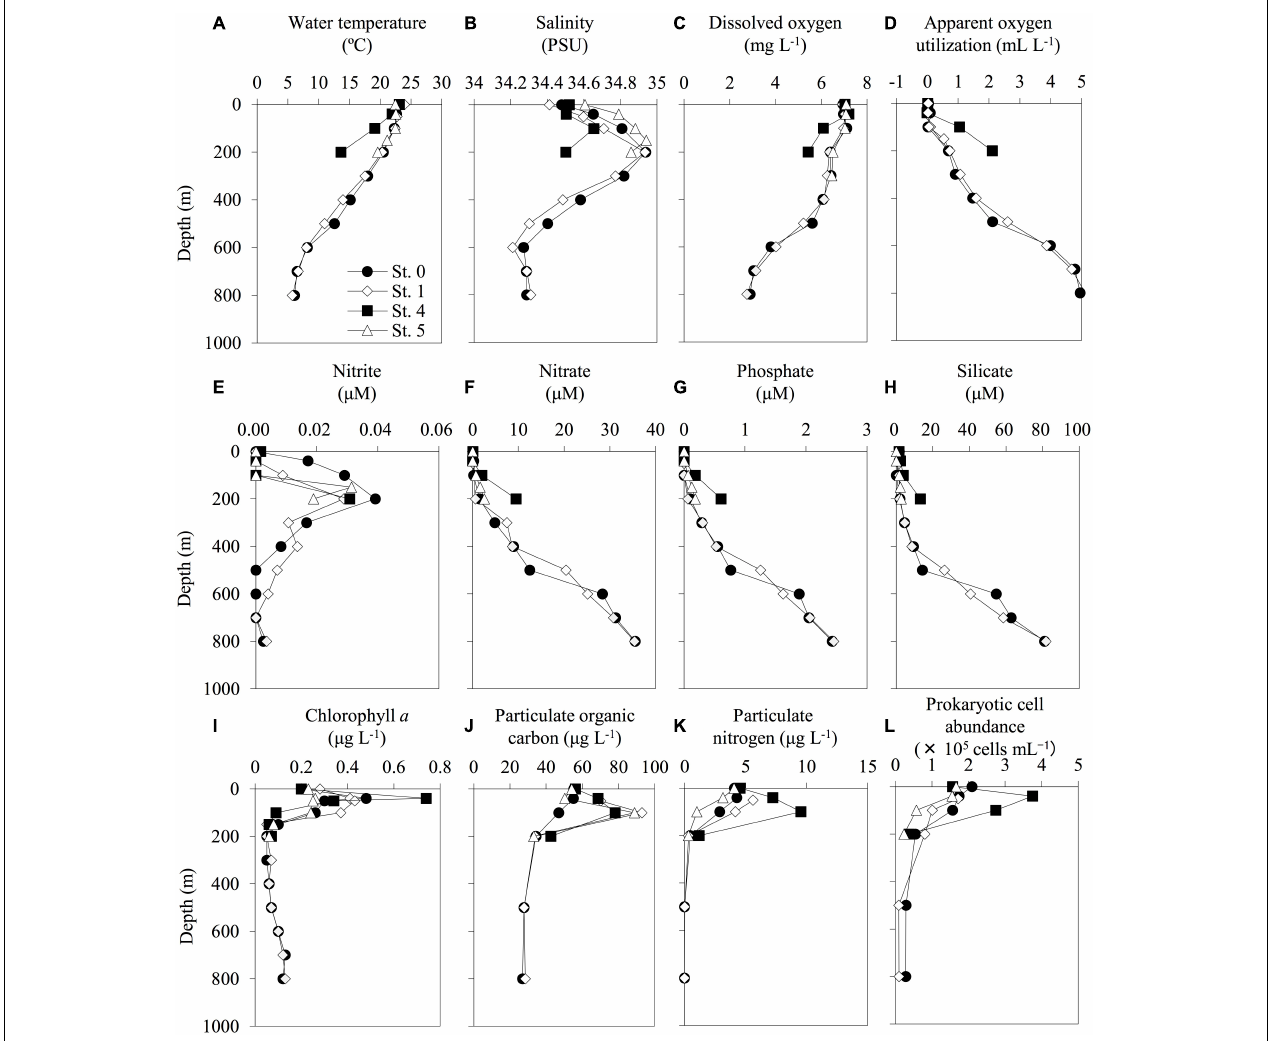
FIGURE 2 | Depth profiles of the environmental factors at each sampling station. The profiles of water temperature (A) , salinity (B) , dissolved oxygen (C) , apparent oxygen utilization (D) , nitrite (E) , nitrate (F) , phosphate (G) , silicate (H) , chlorophyll a (I) , particulate organic carbon (J) , particulate nitrogen (K) , and prokaryotic cell abundance (L) were shown. The profiles do not extend to bottom waters (reference bottom depths in Table 1